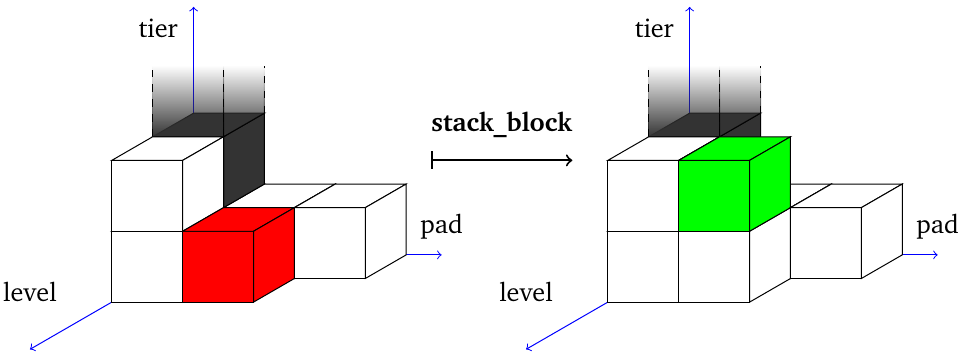
Figure 18: Visualization of the three-dimensional Young diagram partitioning of free- fermionic Hilbert space. The first time stack_block is called on the current block (shown in red), it adds the green block to self.cart and self.blocks in the FFstate instance, so higher tier states may be produced at this level and